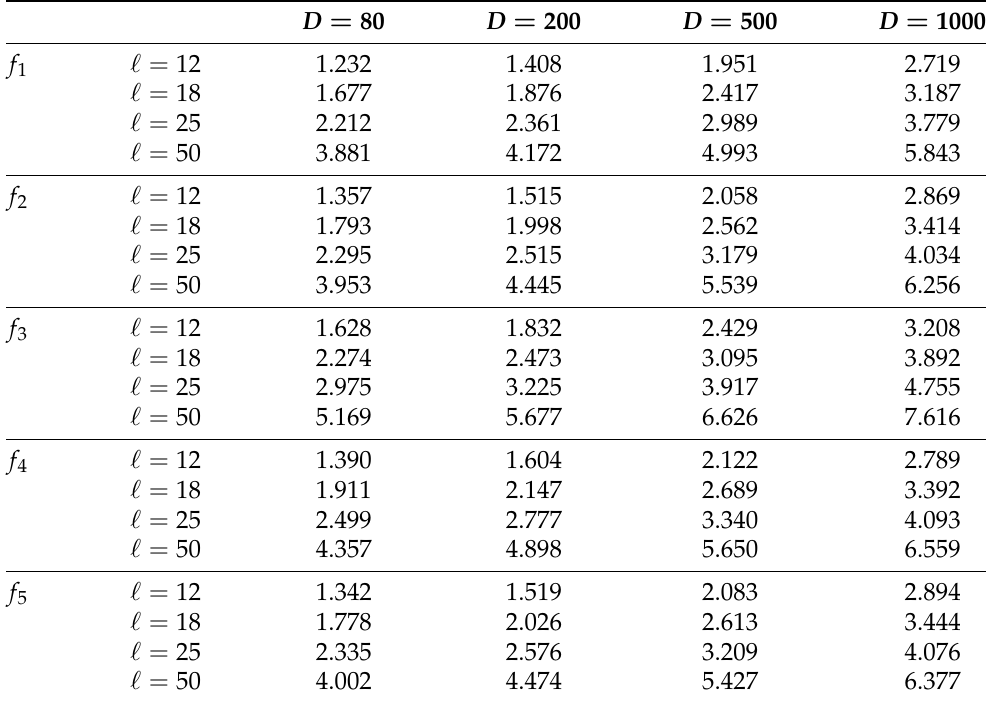
and n = 25. Table 7. Computing time in